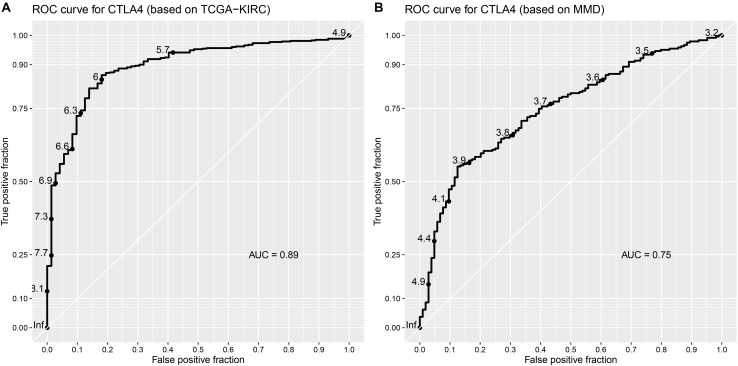
Validation of the prognostic value of CTLA4. (A) ROC curve for CTLA4 based on TCGA-KIRC (AUC = 0.89). (B) ROC curve for CTLA4 based on MMD (AUC = 0.75).